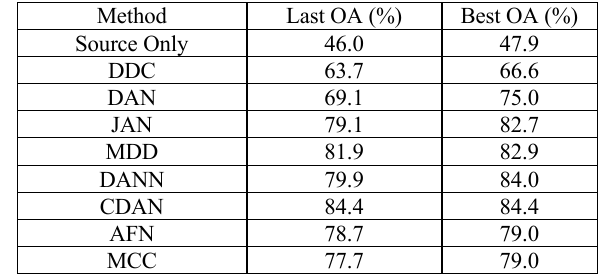
Table 6 . Classification accuracy of each